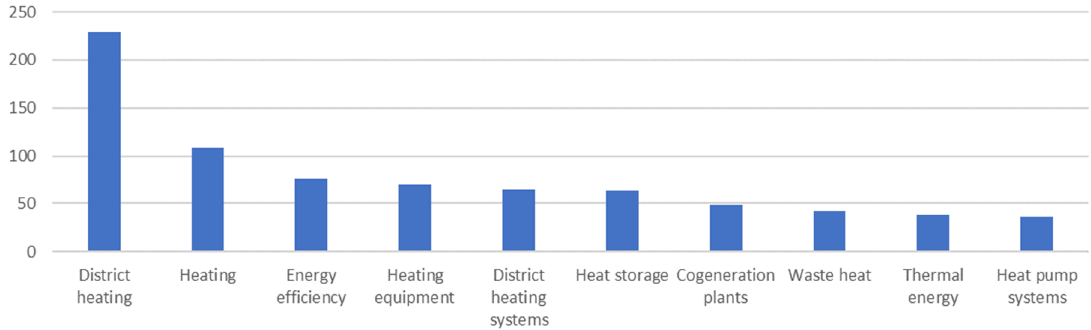
Figure 6 . Heat supply—most frequent keywords (horizontal axis) and the number of articles (vertical axis).